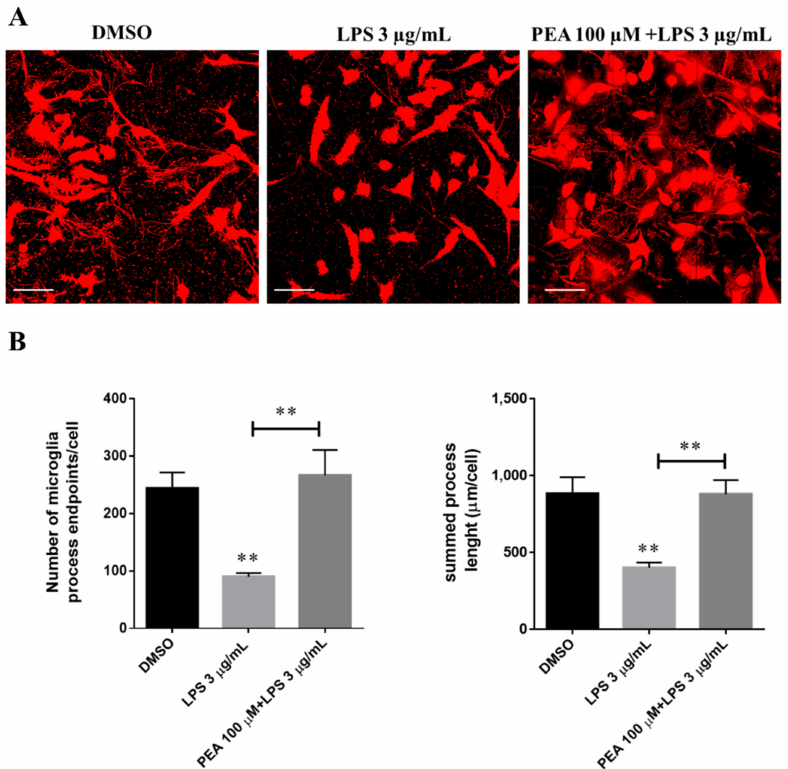
Figure 3. Effect of PEA on microglia ramification in LPS-stimulated N9 cells. N9 cells were seeded on porcine gelatin pre-treated coverslips and then were incubated with 100 µ M PEA at 1 h before treatment with 3 µ g/mL LPS for 6 h. ( A ) Cells were stained with the membrane dye DiI and fixed. Fluorescence images were acquired by a 63 × magnification on Leica TCSSP2 laser scanning confocal microscope. Scale bar: 50 µ m. ( B ) Histograms relative to the quantification of process endpoints/cells and process length/cells. Data are shown as the mean ± S.E.M. of different images analyzed ( n = 5, total number of cells present in each image n = 30, total number of cells analyzed for each group n = 150). Differences between groups were tested for significance by applying the ANOVA test and Tukey post hoc test. ** p <